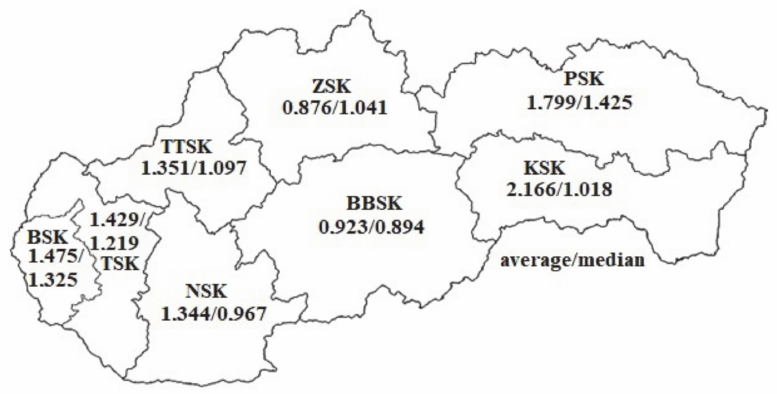
Figure 11. Spatial distribution of results at the level of individual regions—agricultural